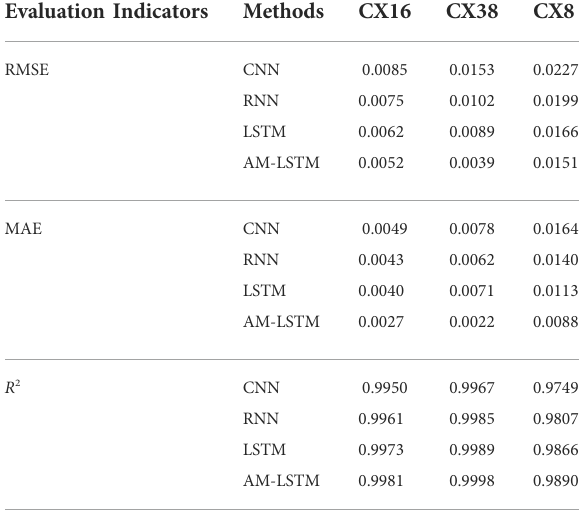
TABLE 4 The predicted evaluation indicators of the proposed method compared with other three capacity prediction methods. Evaluation